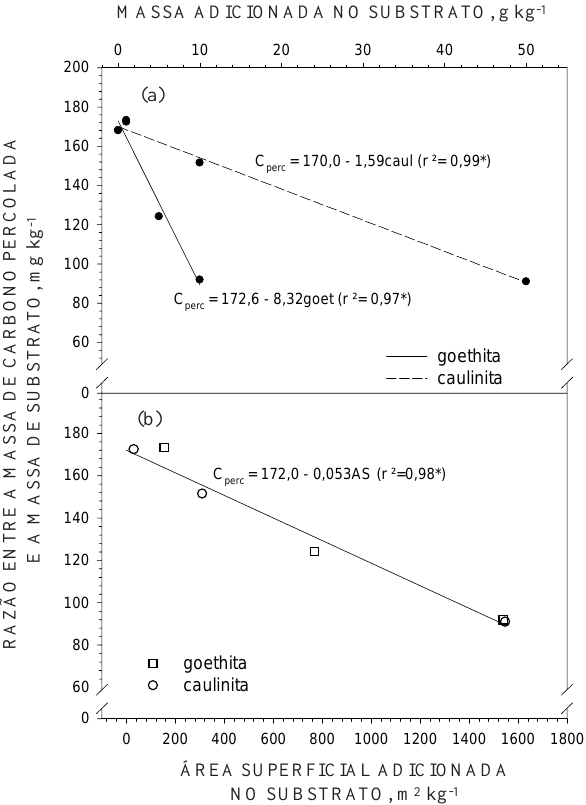
Figura 3. Razão entre a massa percolada acumulada de carbono orgânico solúvel (C ) nas duas perc primeiras percolações (7 e 15 dias de decomposição de palha de milho), considerando a massa de caulinita natural (caul) ou goethita sintética (goet) (a) e área superficial (AS) (b) adicionada nos substratos inorgânicos (* P < 0,05 e NS